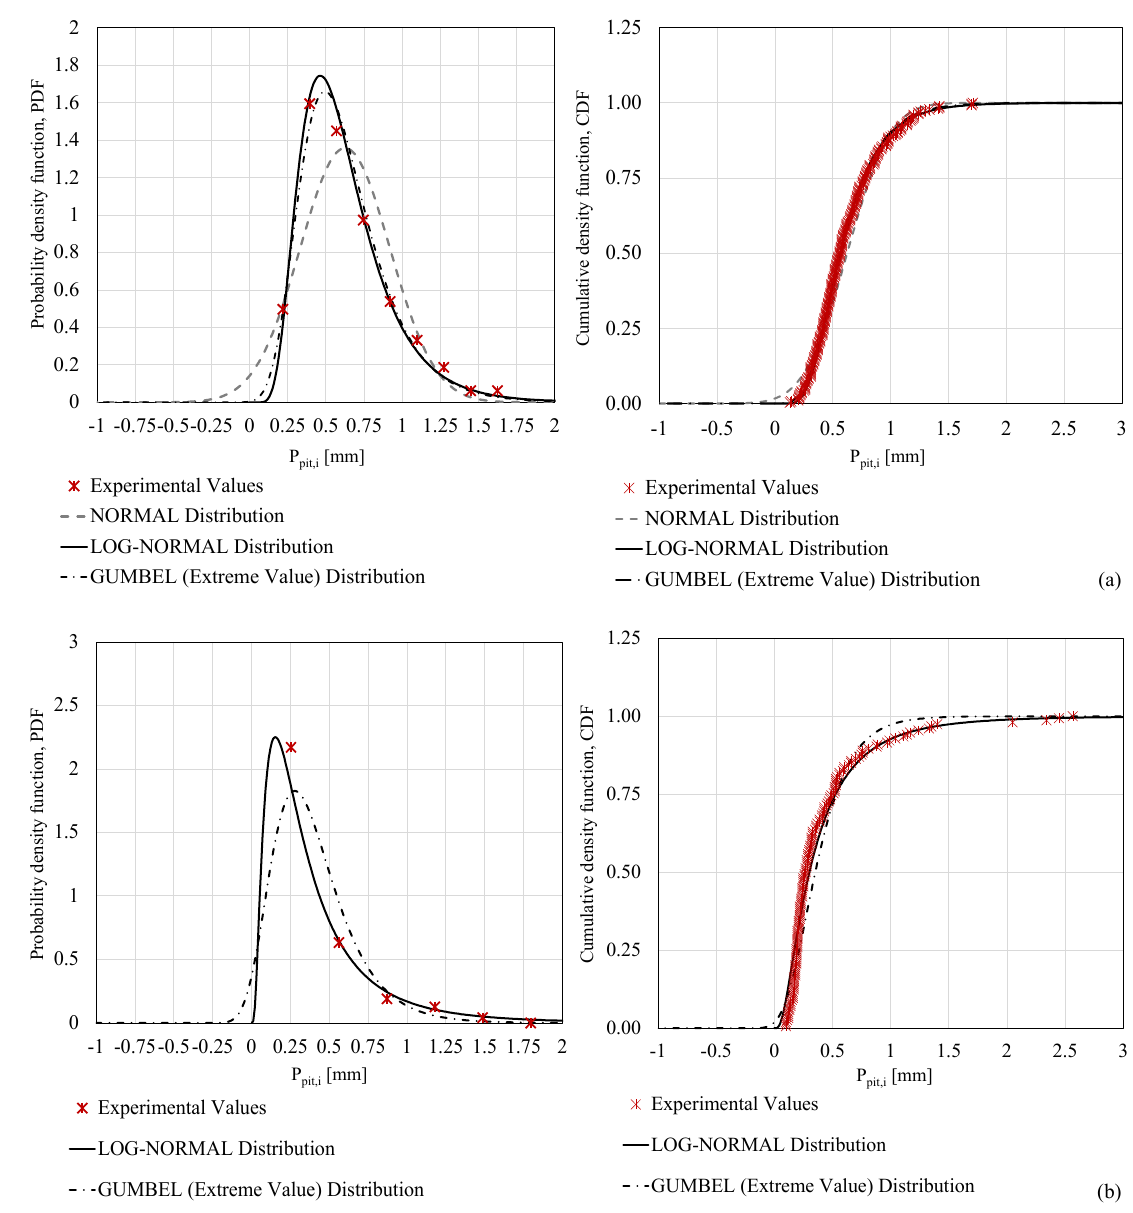
Figure 5. Comparison of adopted probabilistic distribution functions in terms of PDF and CDF for Table 2. Key features of lognormal distributions of corroded prestressing strands.